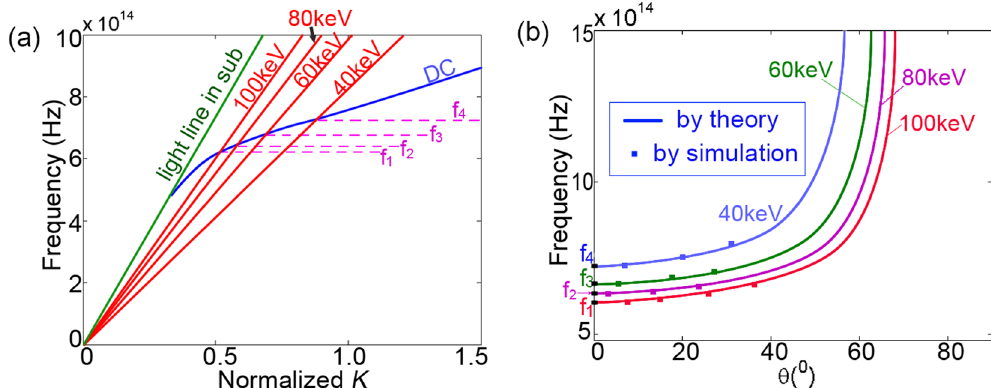
Figure 4. ( a ) Calculated dispersion curves of the nano-film and beam lines. ( b ) The frequency versus direction. The ‘ f ’–‘ f ’ are threshold (cutoff) frequencies respectively for beam energies of 40 keV, 60 keV, 80 keV, and 1 4 100